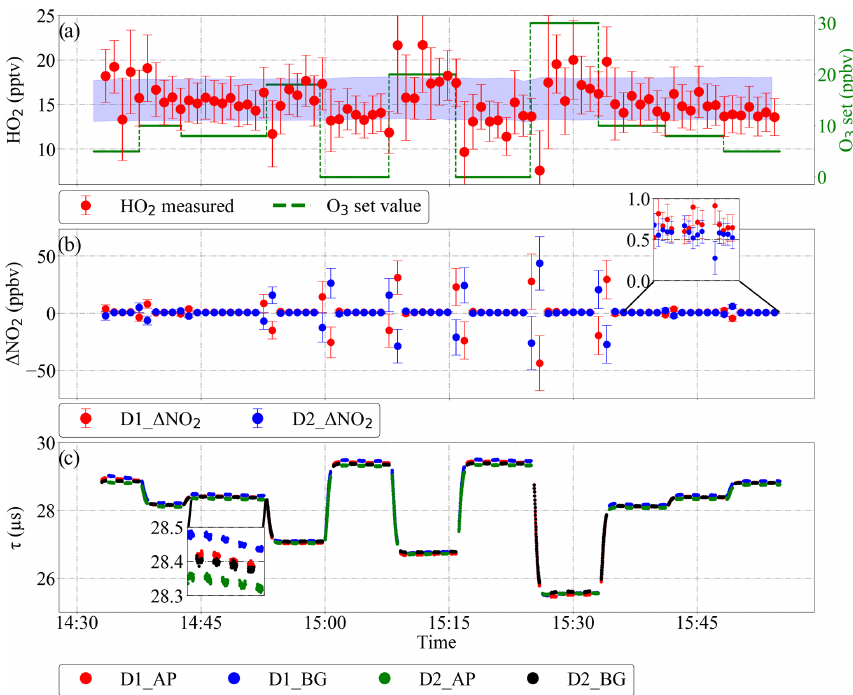
Figure 17. HO 2 retrieval under controlled changing of the O 3 background concentration using DUALER I: (a) retrieved HO 2 and O 3 variation. The blue shaded area in panel (a) shows the HO 2 produced in the radical source (15%, i.e. 2 σ , uncertainty); (b) (cid:49) NO 2 retrieved from detector 1 (red) and detector 2 (blue); (c) ring-down time from both detectors. D1: detector 1; D2: detector 2; AP: amplification mode, BG: background